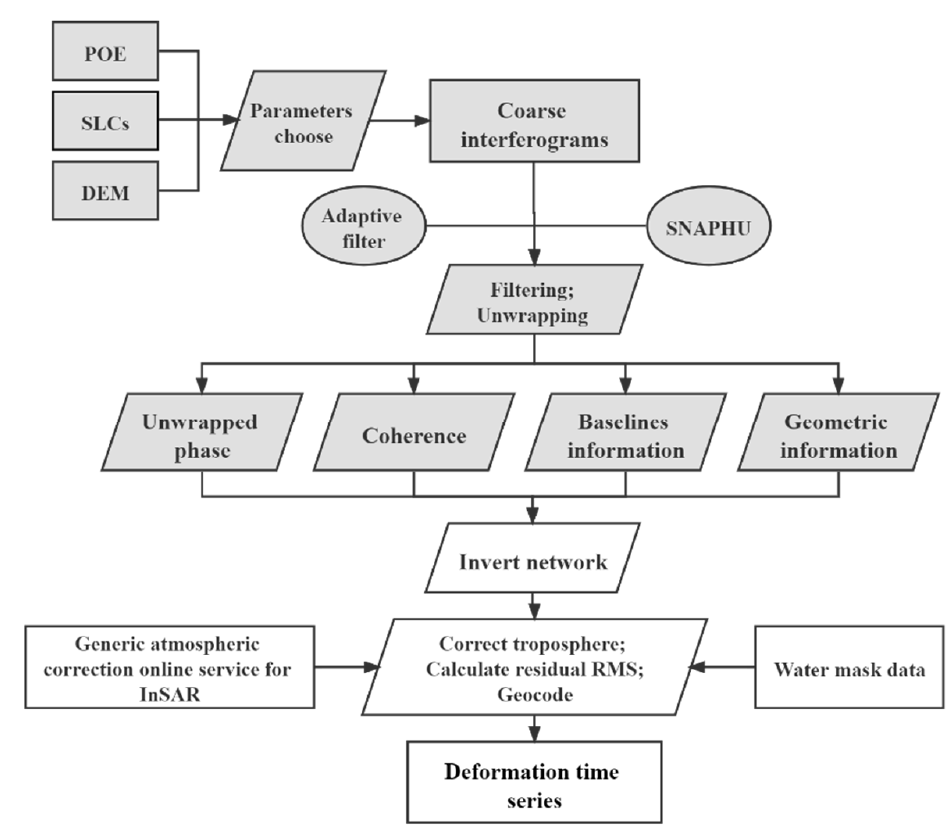
Figure 2. SBAS-InSAR processing flow. The gray box represents ISCE processing, while the white box represents Mintpy processing flow.